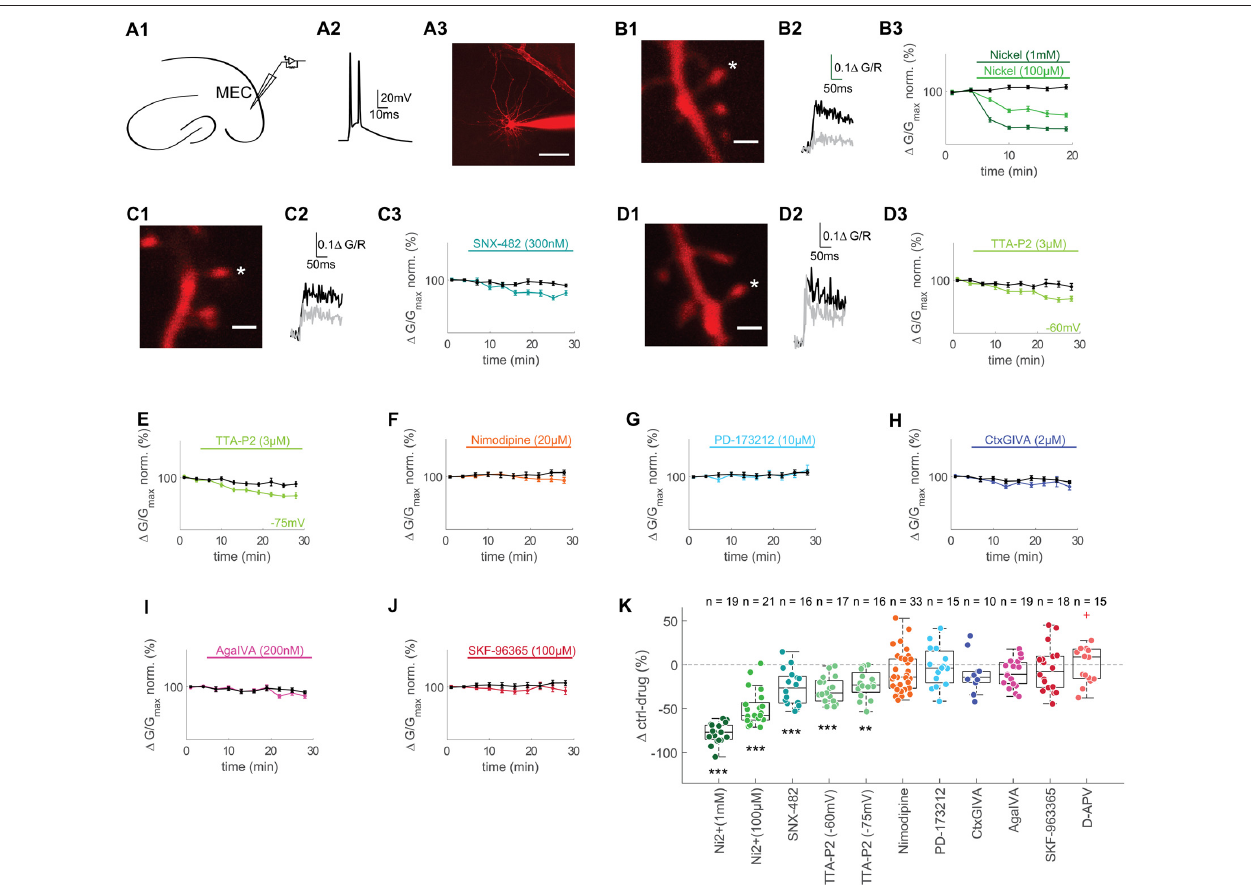
FIGURE 1 | T- and R-type voltage gated Ca 2 + channels (VGCCs) contribute to backpropagating action potentials (bAPs)-Ca 2 + transients in spines of layer II MEC cells. (A1) Illustration of recording pipette positioning in layer 2 of the MEC. (A2) Representative AP doublet (100 Hz) evoked by current injection to induce the bAP-Ca 2 + transients. (A3) Representative MEC layer 2 cell with recording pipette. Scale bar: 50 µ m. (B1) Z-projection of the imaged spine (marked with an asterisk). Scale bar: 2 µ m. (B2) Averaged fluorescence traces at baseline (0–5 min, black) and 10–15 min (gray) after wash-in of 1 mM Ni 2 + . (B3) Time plot of normalized, binned (3 min) doublet evoked bAP-Ca 2 + transients under control conditions (black) and wash-in of 1 mM (dark green) or 100 µ M Ni 2 + (lightgreen) after 5 min of baseline. (C1,D1) Z-projections of the imaged spines (marked with asterisks). Scale bars: 2 µ m. (C2,D2) Averaged fluorescence traces 0–5 min (black) and 20–25 min (gray) after wash-in of 300 nM SNX-482 (C2) and 3 µ M TTA-P2 (D2) . (C3,D3,E–J) Time plots of normalized, binned (3 min) doublet evoked bAP-Ca 2 + transients under control conditions (black) and wash-in of 300 nM SNX-482 (C3) , 3 µ M TTA-P2 at − 60 mV (D3) , 3 µ M TTA-P2 at − 75 mV (E) , 20 µ M Nimodipine (F) , 10 µ M PD-173212 (G) , 2 µ M CtxGIVA (H) , 200 nM AgaIVA (I) and 100 µ M SKF-96365 (J) after 5 min of baseline. (K) Median box plot illustrating the contribution of T- and R-type (1 mM Ni 2 + and 100 µ M Ni 2 + ), R-type (SNX-482), T- type (TTA-P2 − 60 mV and − 75 mV), L-type (Nimodipine), N-type (PD-173212 and CtxGIVA), P/Q-type (AgaIVA), TRPC calcium channels and NMDARs to doublet evoked bAP-Ca 2 + transients measured as ∆ of the averaged time-matched interleaved control value and the drug effect 10–15 min after Ni 2 + wash-in and 20–25 min after wash-in of all other drugs, ∗∗ p < 0.01, ∗∗∗ p < 0.001. The red cross